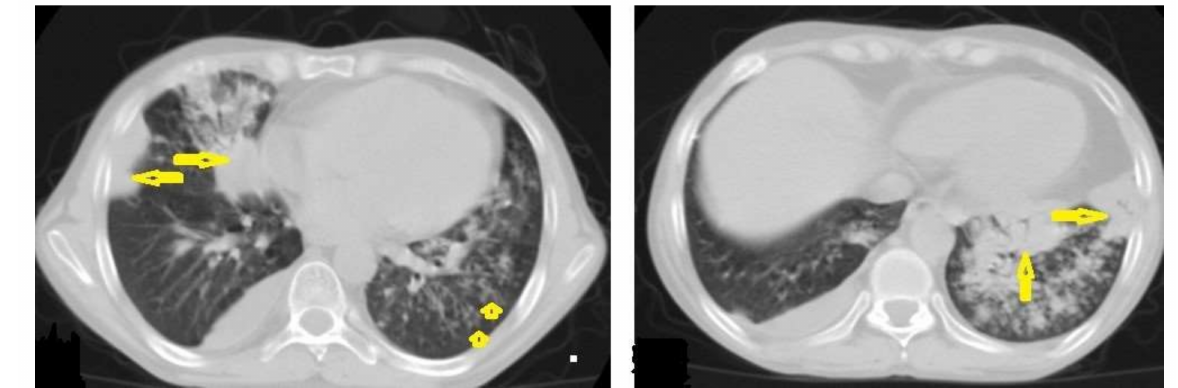
Figure 2. Active TB in a 27-year-old man with extensive endobronchial spread. Selected axial images of chest CT show extensive endobronchial spread characterized by patchy consolidations (long arrows) in the right middle and left lower lobes with tree-in-bud nodules (short arrow) more involved the left lung. Mild right pleural effusion and mild pericardial effusion appear in both